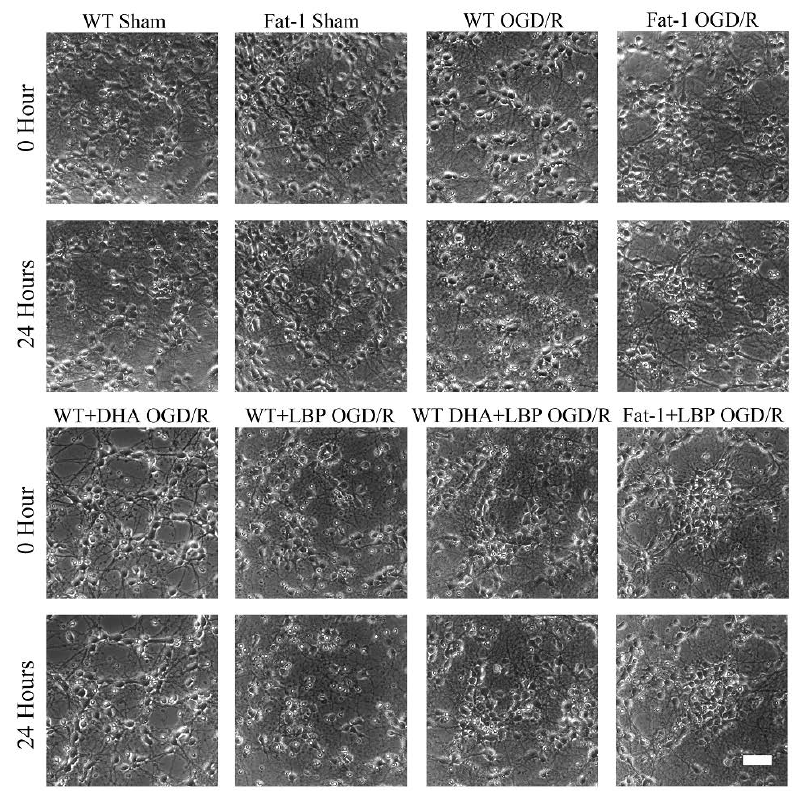
Figure 2. Primary cortical neurons were protected against OGD/R injury after LBP and ω -3 PUFAs treatment. Phase contrast images showing the morphological changes of the primary cultured neurons prior or post OGD/R injury. Scale bar: 50